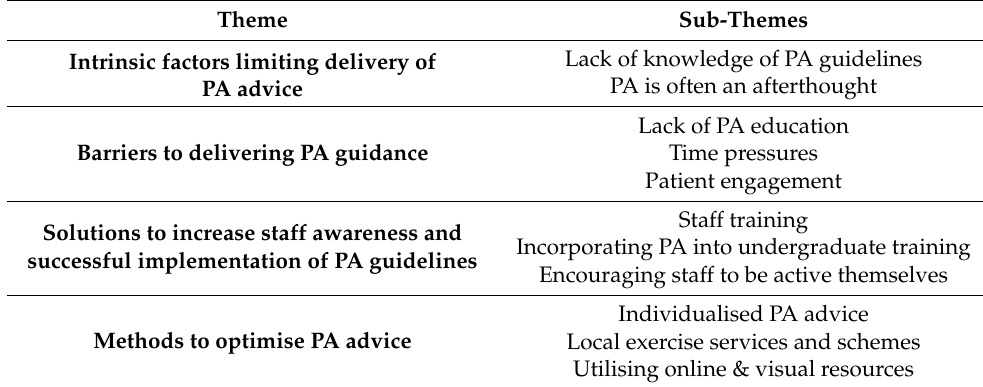
Table 2. Themes and